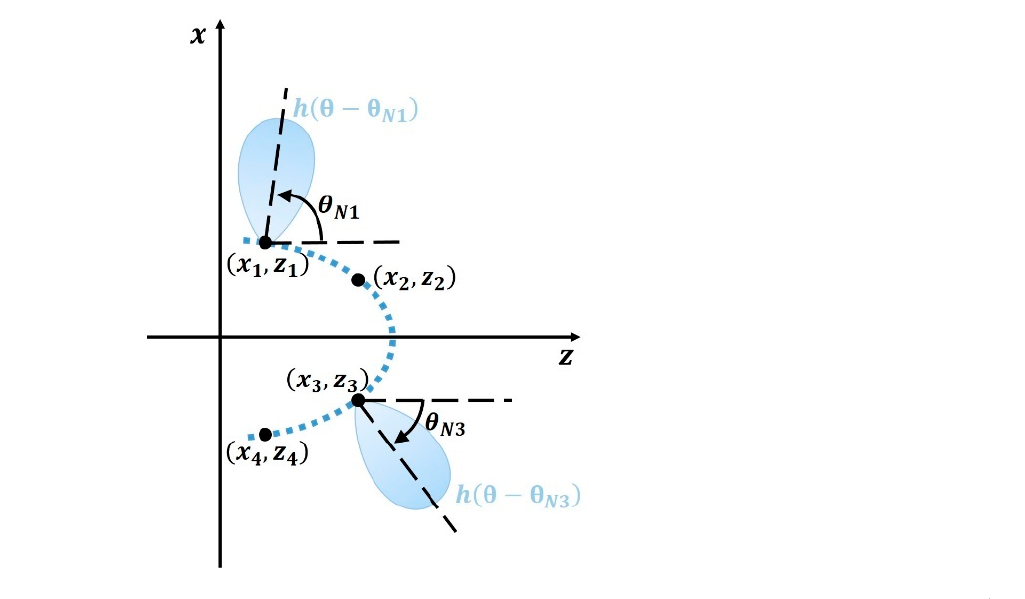
Figure 1. The geometrical setting of the array source: the m -th element location is ( x m , z m ) with element factor h ( θ − θ Nm )